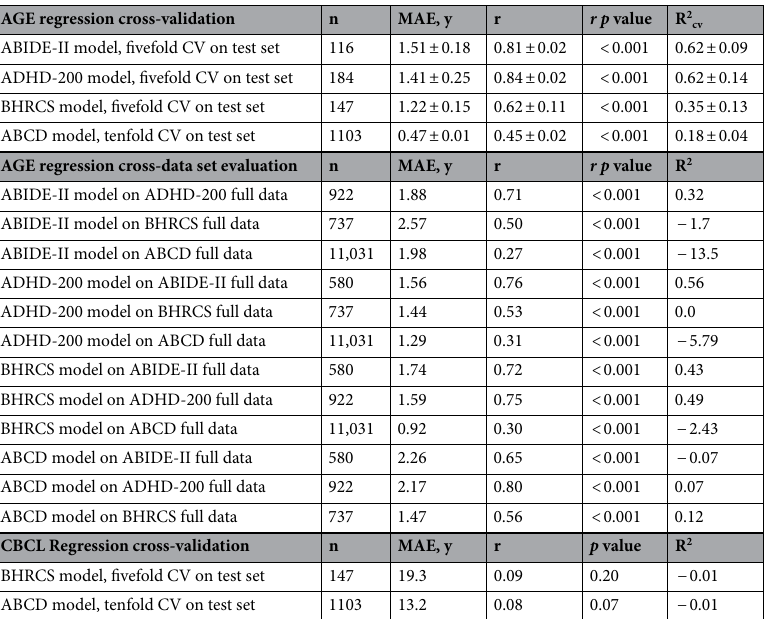
Table 2. Regression performance metrics. The performance indicators are presented in mean values ± standard deviation. The chosen model for between dataset evaluation is the best-performing from the cross-validation. In column titles, n is the sample size, MAE is the mean absolute error, r is the Pearson’s correlation between prediction and target, and R 2 is the prediction R 2 (also known as cross-validation R 2 or q 2 ). While r shows how correlated predictions and targets are, R 2 expresses how much of the target’s variability can be explained by predictions. Note that good MAEs (low values) may present poor correlations due to a narrow age range in the evaluated dataset. p values lower than 0.001 were omitted for clarity. CBCL Child behavior checklist total score.